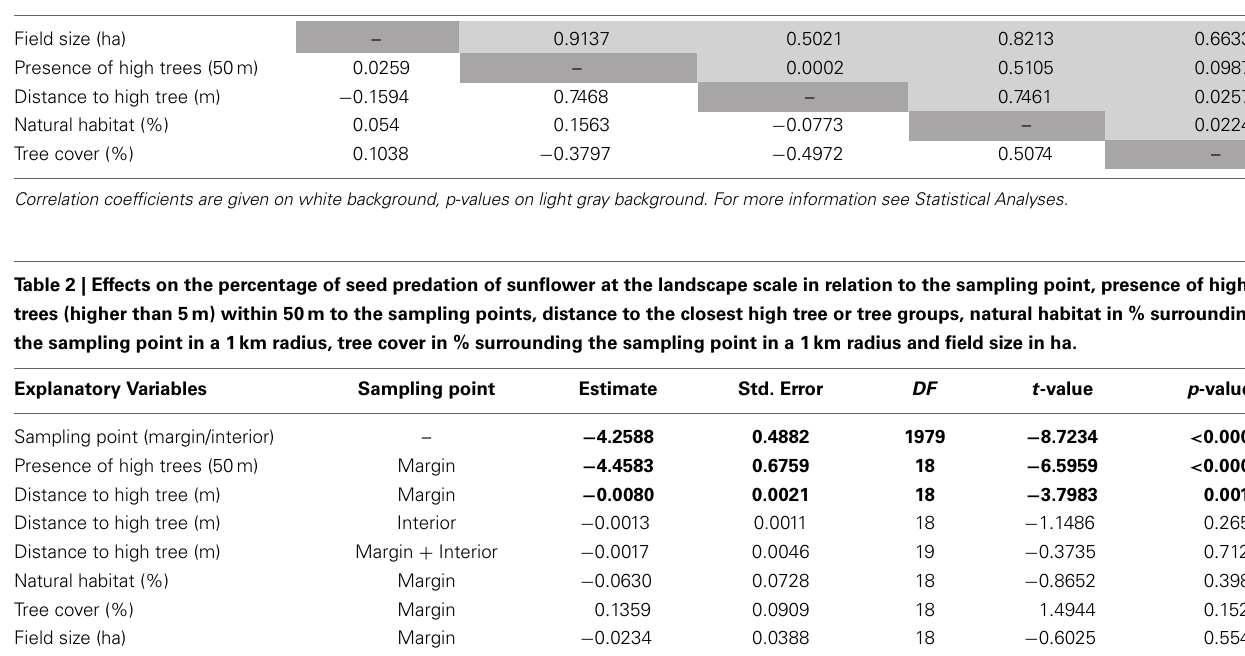
Significant relationships are highlighted in bold (Std. Error is the standard Error; DF stands for Degrees of Freedom). Data was analyzed with generalized linear mixed models. For more information concerning the statistical analysis see Statistical